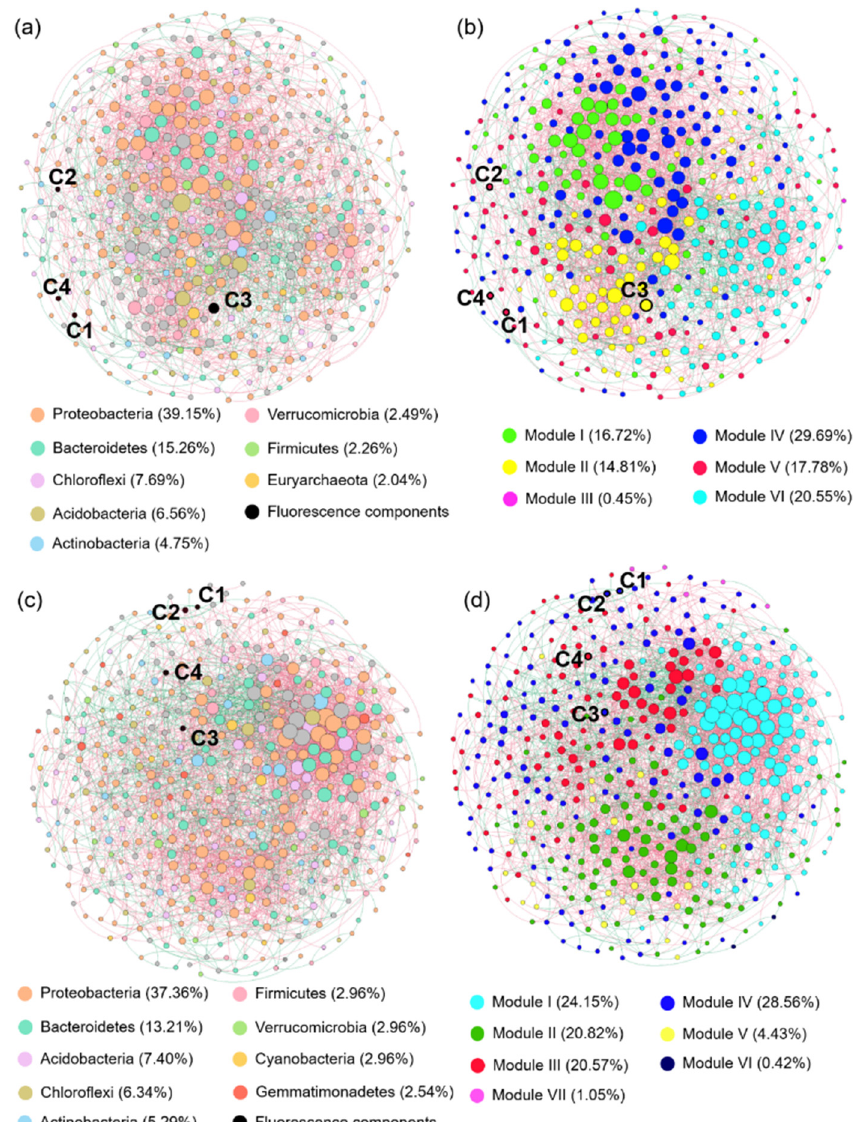
Figure 7. Co-occurrence network based on Random Matrix Theory (RMT) model in ( a , b ) winter and ( c , d ) summer. The size of each node in the network is proportional to the degree of connectivity, and the nodes are colored according to phylum ( a , c ) and different types of modularity classes ( b , d ), respectively. Red and green edges indicate positive and negative correlations, respectively.